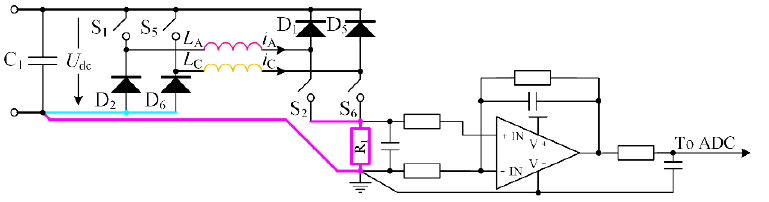
Figure 6. Current detection circuit using a shunt resistor with non-isolated single-supply non-inverting amplifier.